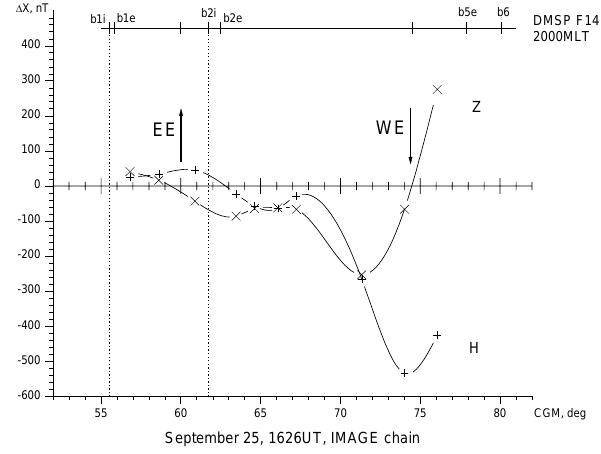
Fig. 6. As Fig. 5, but at 12:48 UT on 25 September 1998. Measure- ments from the DMSP F13 pass over auroral latitudes at 17:00 MLT. Fig. 7. As Fig. 5, but at 16:26 UT 25 September 1998. Measure- ments from the DMSP F14 pass over auroral latitudes at 20:10